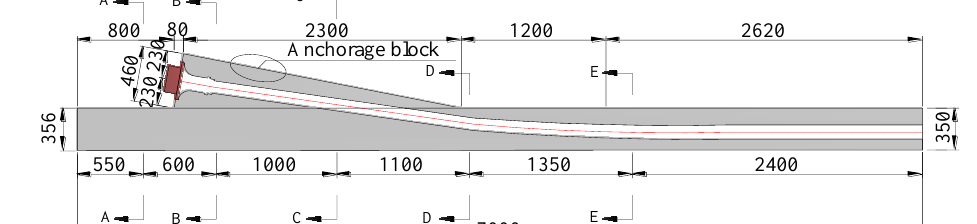
Figure 5. The test section of the top slab specimen (unit: mm).